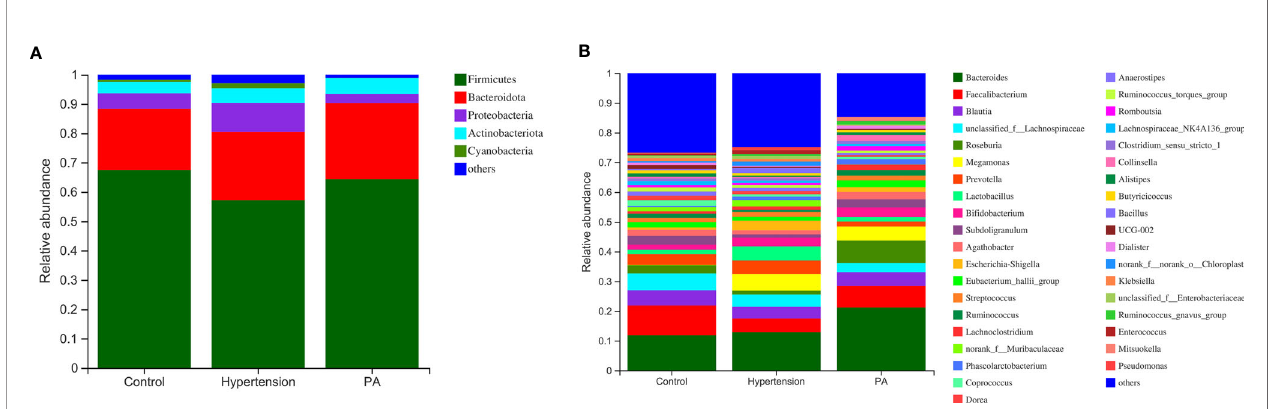
FIGURE 2 | Distribution of gut microbiota between primary aldosteronism (PA) patients, primary hypertension patients, and healthy controls. Relative abundances of the major bacteria at the (A) phylum and (B)